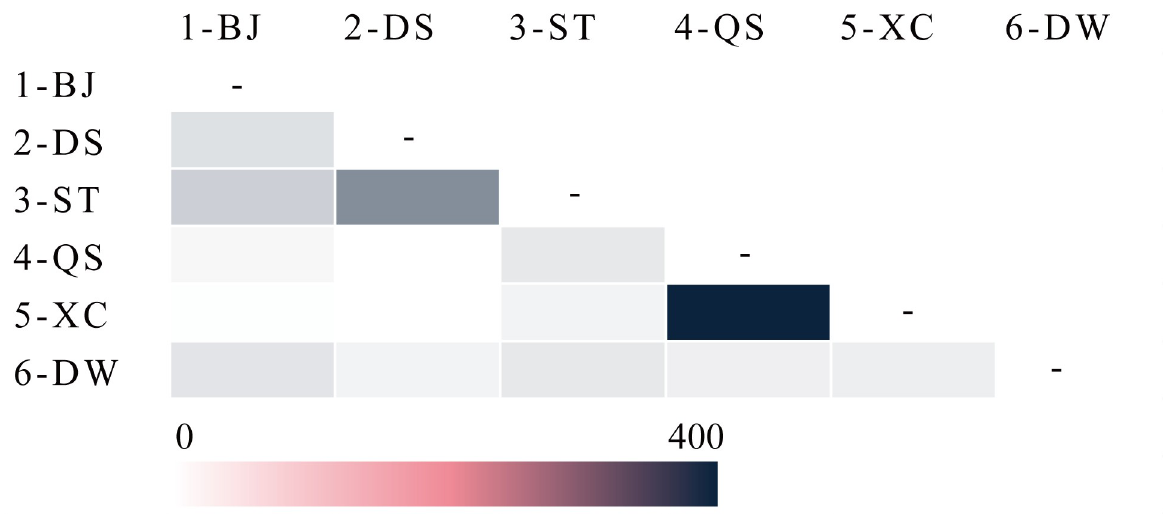
Fig 4. Contemporary gene flow among populations of Spartina alterniflora in Guangxi, the color shades represented levels of gene flow.